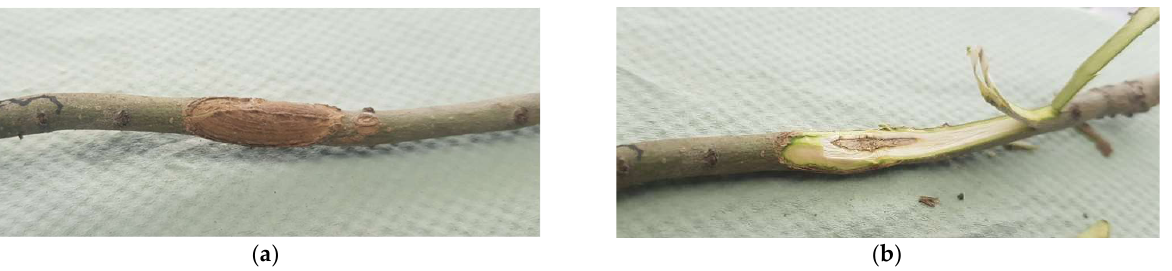
Figure 4. Samples of saplings sprayed with BTHWA prior to and post inoculation (S1): sealed wound ( a ); lesion ( b ).